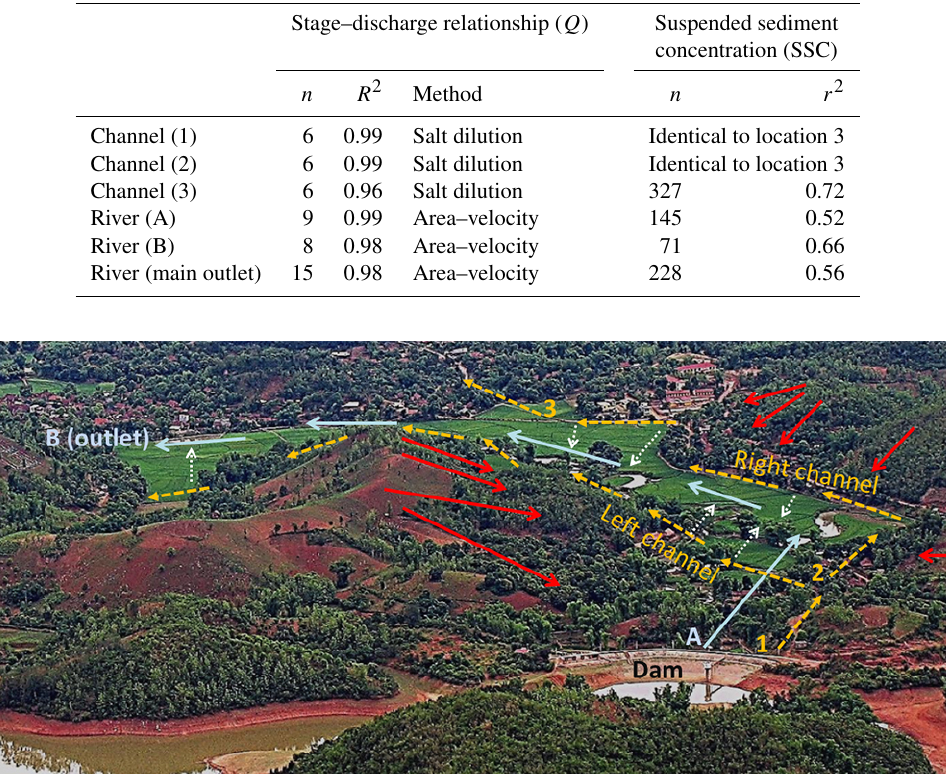
Figure 1. Sediment sources and water flows into and out of paddy rice fields in Chieng Khoi watershed. The dotted yellow arrows show the irrigation channel leaving the reservoir and splitting in two, feeding the two banks of paddy rice. The rice fields subsequently drain into the river, which is indicated by the blue arrows. During rainfall, runoff generated on the uplands flows into the irrigation channel and the paddy fields (red arrows). Measurement locations are indicated with numbers in the channel (1: reservoir outflow, 2: channel split, 3: channel leaving watershed) and with letters in the river (A: river before paddy fields drainage, B: river after paddy fields